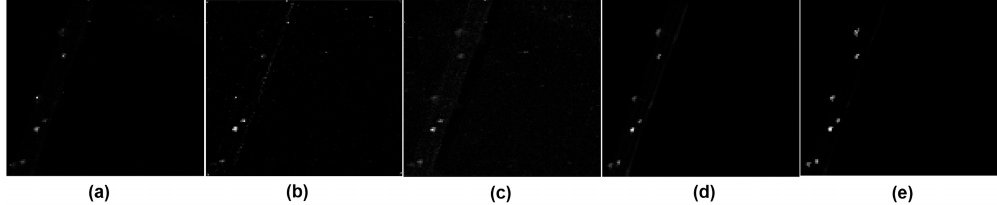
Figure 8. The comparison in area under curve (AUC) between RSLAD and four comparative methods on the four HSI datasets: ( a ) PaviaC; ( b ) San Diego; ( c ) Botswana; and ( d ) HyMap.